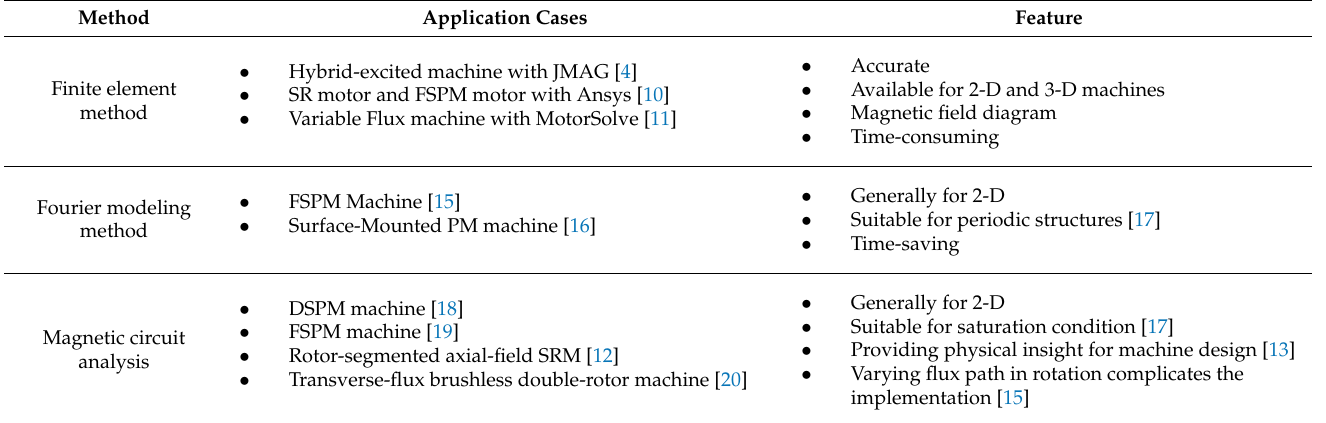
Table 1. Comparison of different analysis